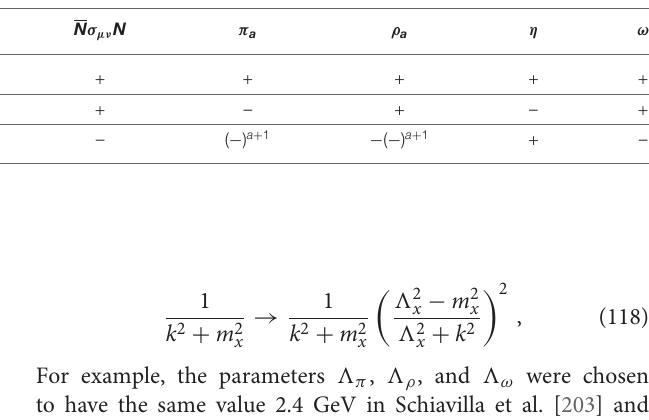
TABLE 2 | Transformation properties of fermion bilinears with different elements of the Clifford algebra and various meson fields under hermitian conjugation (H), parity (P), and charge conjugation (C).